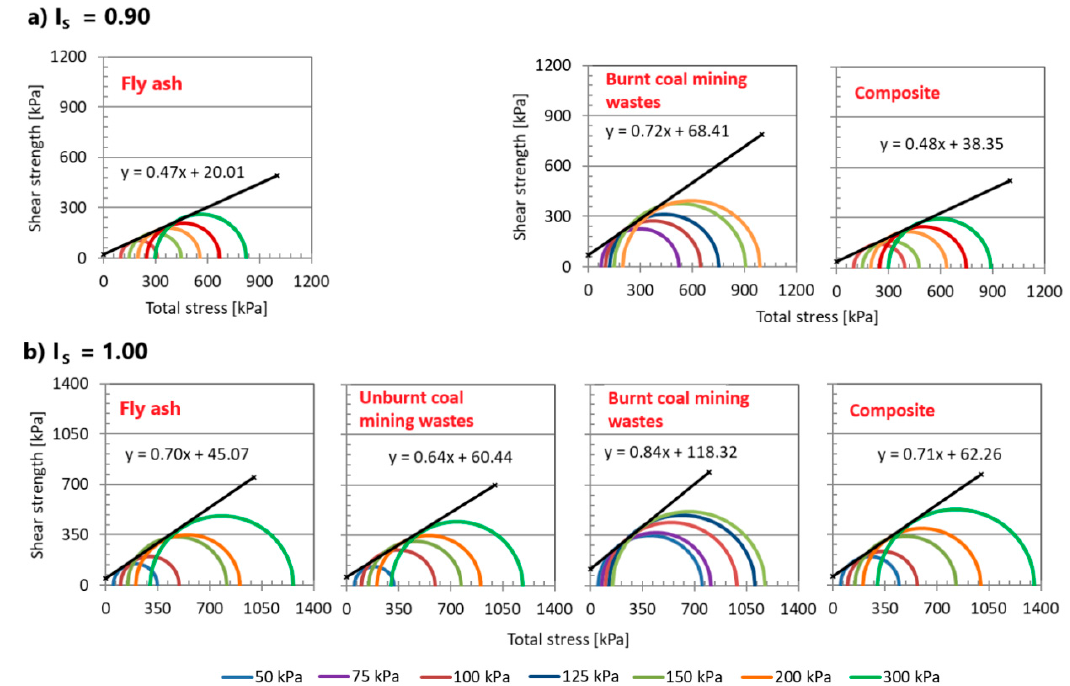
Figure 5. Shear strength line of the tested materials as a tangent to Mohr’s circles.